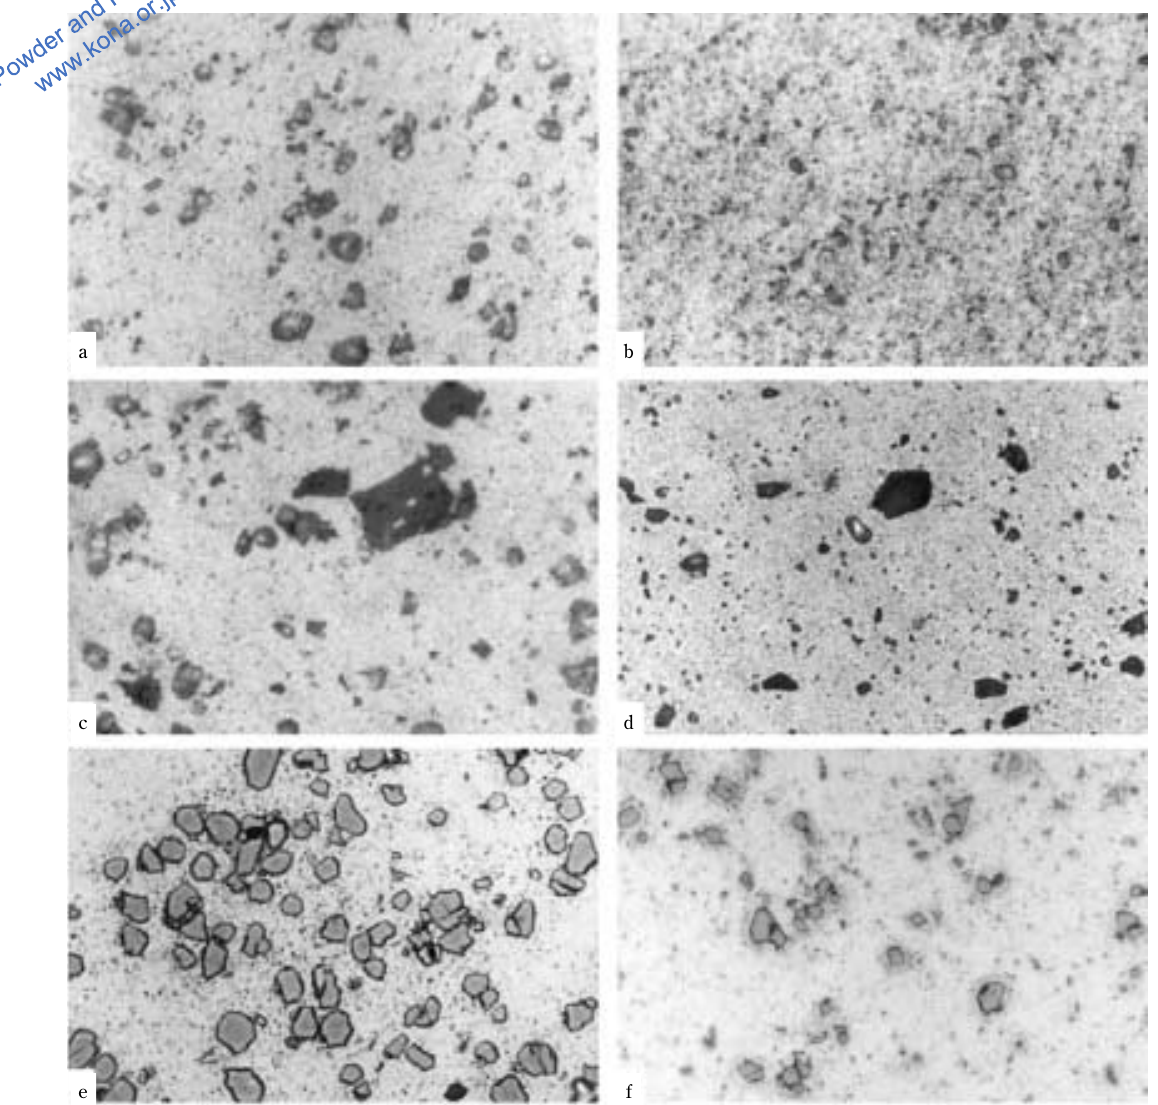
Fig. 5 Microstructures of PM6061 reinforced with Si 3 N 4 (a and b), AlN (c and d), and ZrB 2 (e and f), extruded from the mixed powders (a, c and e) and from the composite powders (b, d and f).